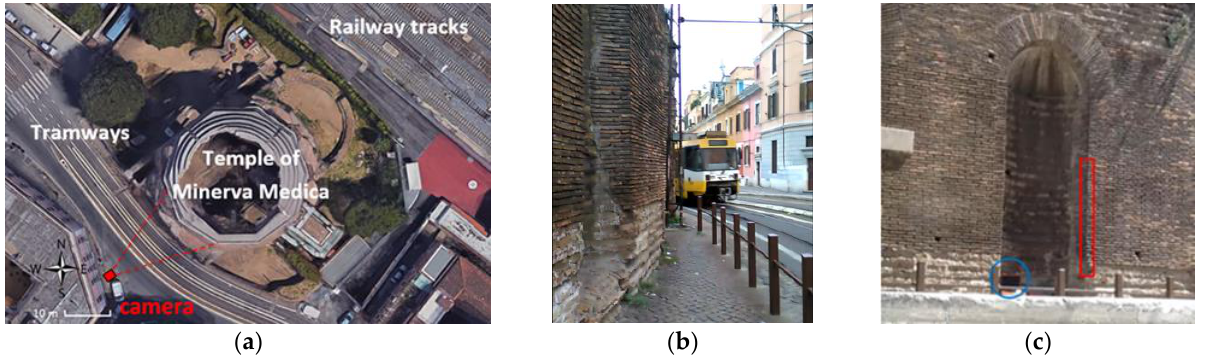
Figure 6. The so-called Temple of Minerva Medica: ( a ) aerial view with camera position (from Google Maps); ( b ) a tram passing by very close to the south wall of the monument; ( c ) the ROI used for extracting the MM signal is enhanced by the red rectangle at the niche corner’s edge.